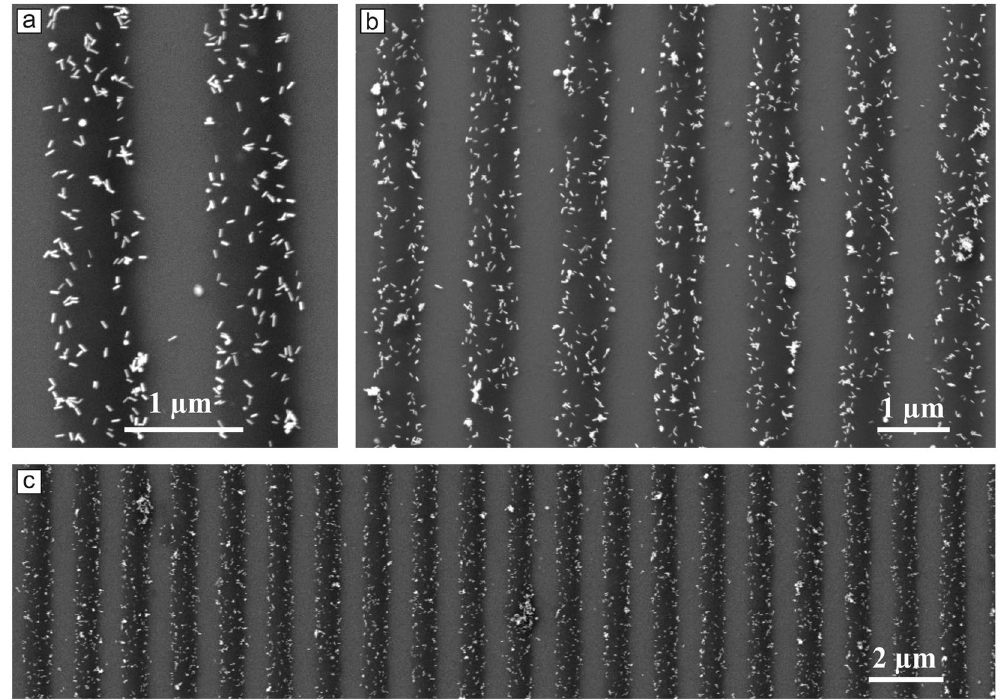
Figure 7. SEM micrographs of the polymer wires filled with gold nano-rods. ( a ) The gold nano-rods are randomly situated within the nano-wires. ( b and c ) Larger overview of the ensemble of many